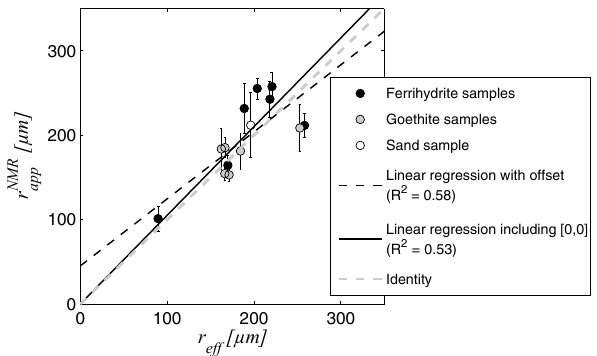
Figure 8. Correlation of effective radius estimates from grain size distribution r eff and the apparent radius estimates from NMR r NMR app , the regression coefficient for fitting with constant offset is 0.79 and for fitting without offset, i.e. including the point [0, 0], is